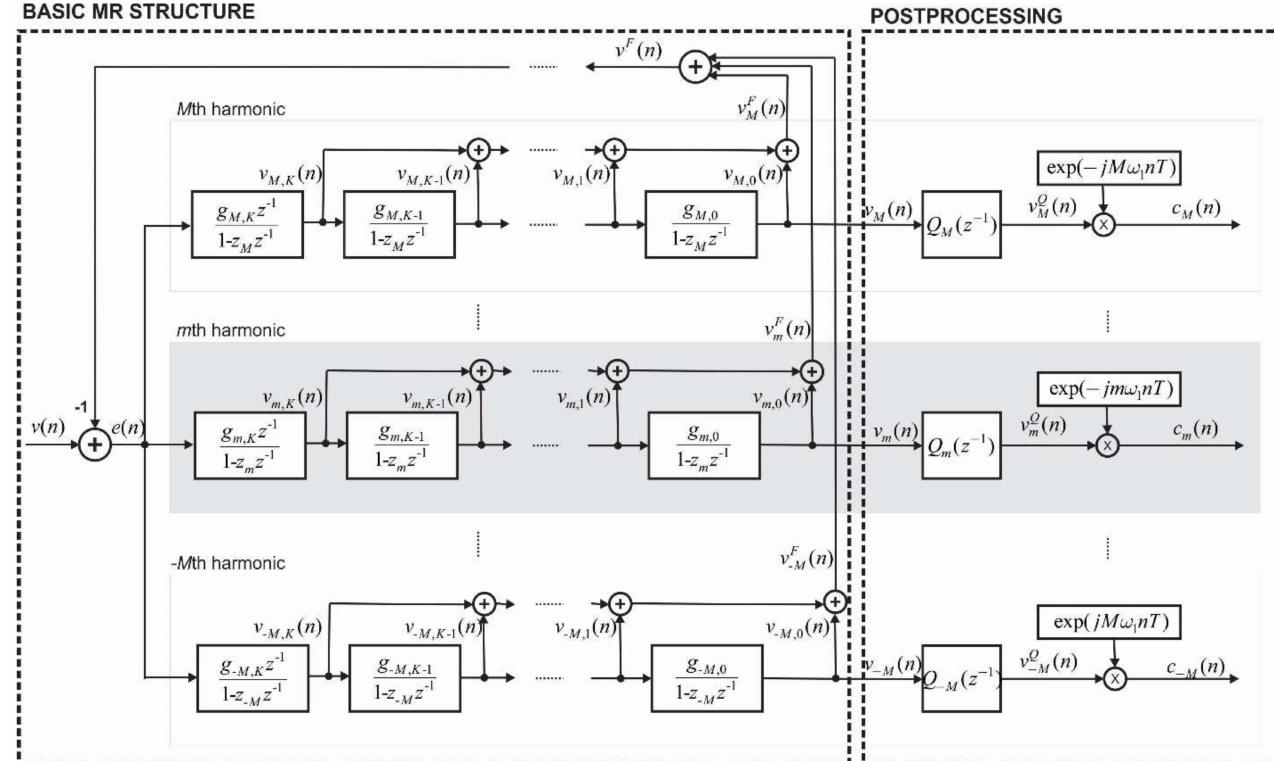
Figure 1. Block diagram of the K-type MR-based harmonic